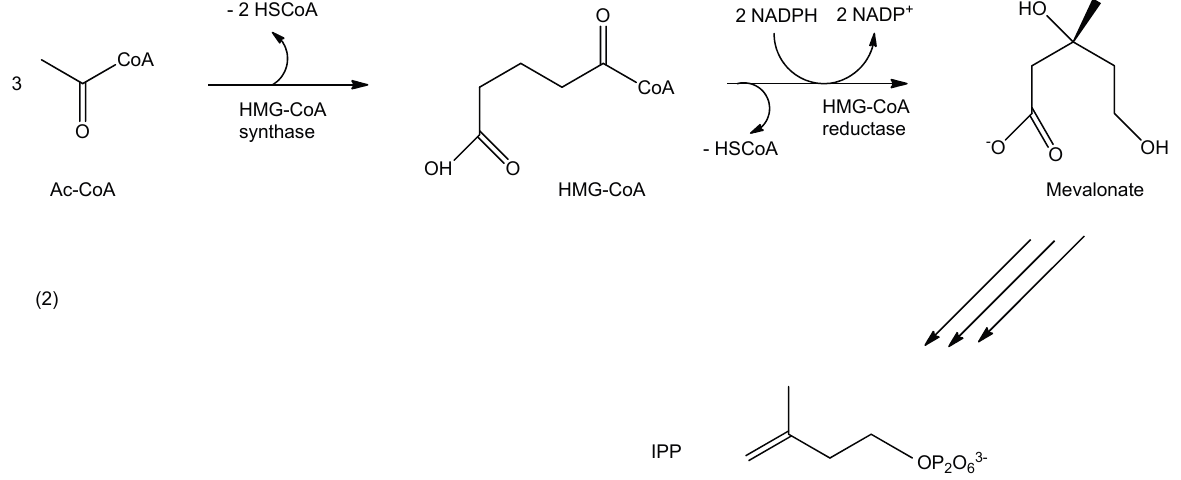
Figure 6. Select steps of the IPP biosynthesis in most bacteria, fungi and plantae. Pyruvate is condensed with glyceraldehyde-3-phosphate to generate 1-deoxy- D -xylulose-5-phosphate (DXP) in the presence of the 1-deoxy- D -xylulose-5-phosphate synthase (DXS), which is then transformed into 2- C -methyl- D -erythriol-4-phosphate (MEP) in the presence of the 2- C -methyl- D -erythriol-4-phosphate reducto-isomerase (IspC) using energy provided by the hydrolysis of nicotinamide adenine dinucleotide phosphate (HADPH) to nicotinamide adenine dinucleotide (NADH). MEP is then used for further functionalization to yield iso-pentenyl-diphosphate (IPP) as precursor for ubiquinone and its derivatives (see the text for